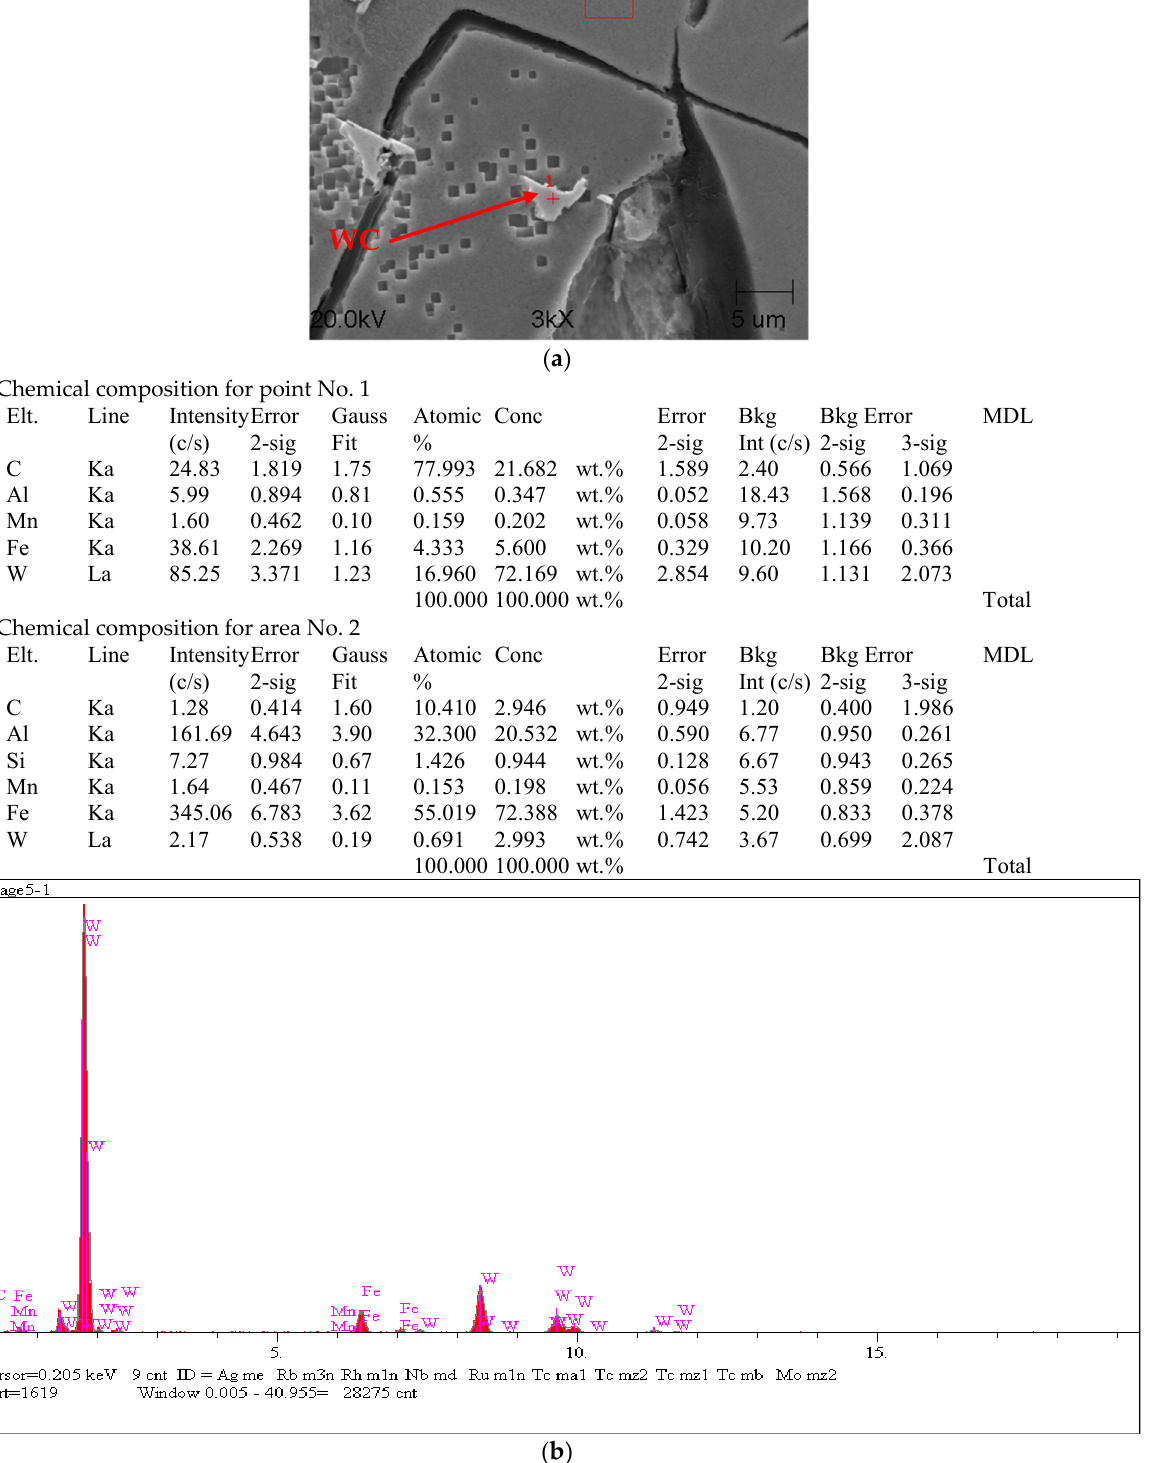
Figure 9. SEM microstructure ( a ) of high-aluminum cast iron with the addition of tungsten marking for the chemical composition of the area: no. 1 tungsten carbide, no. 2 metal matrix and graphite in the structure and its EDS X-ray microanalysis ( b ).